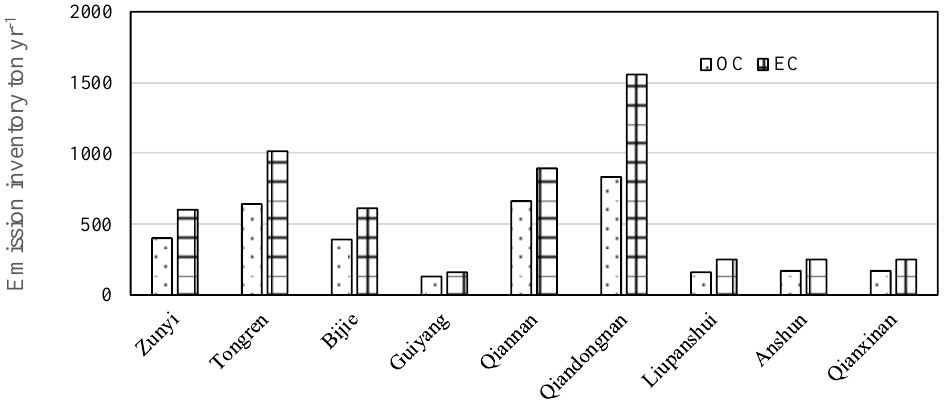
Figure 7. OC and EC emissions from cities/counties in Guizhou Province in 2019.